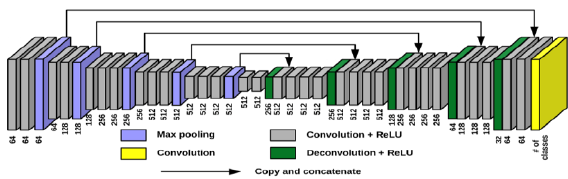
Figure 5: U-net model used for landcover